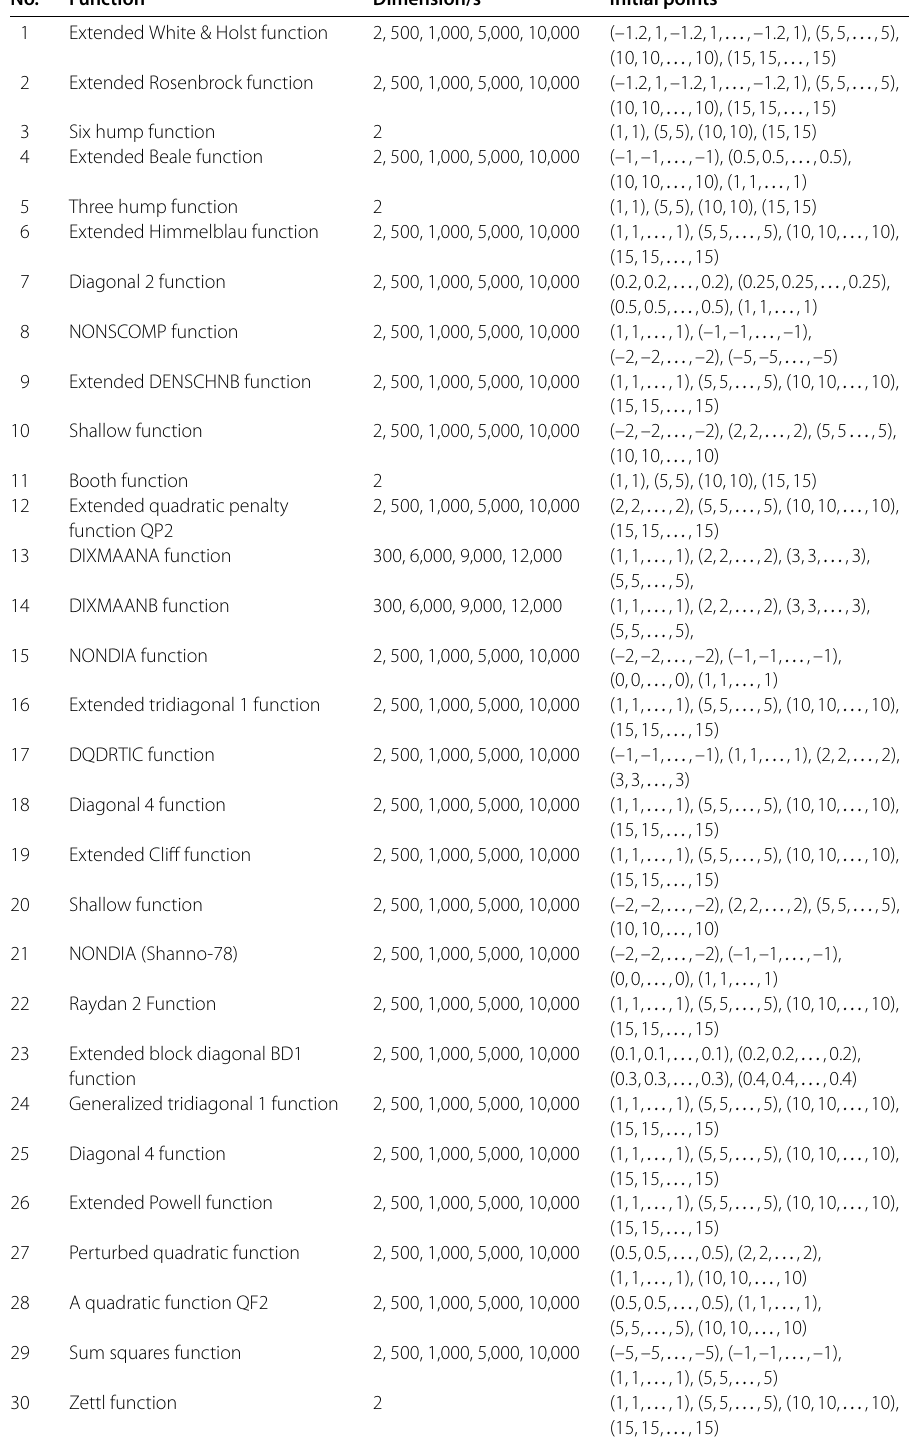
Table 1 A list of test problem